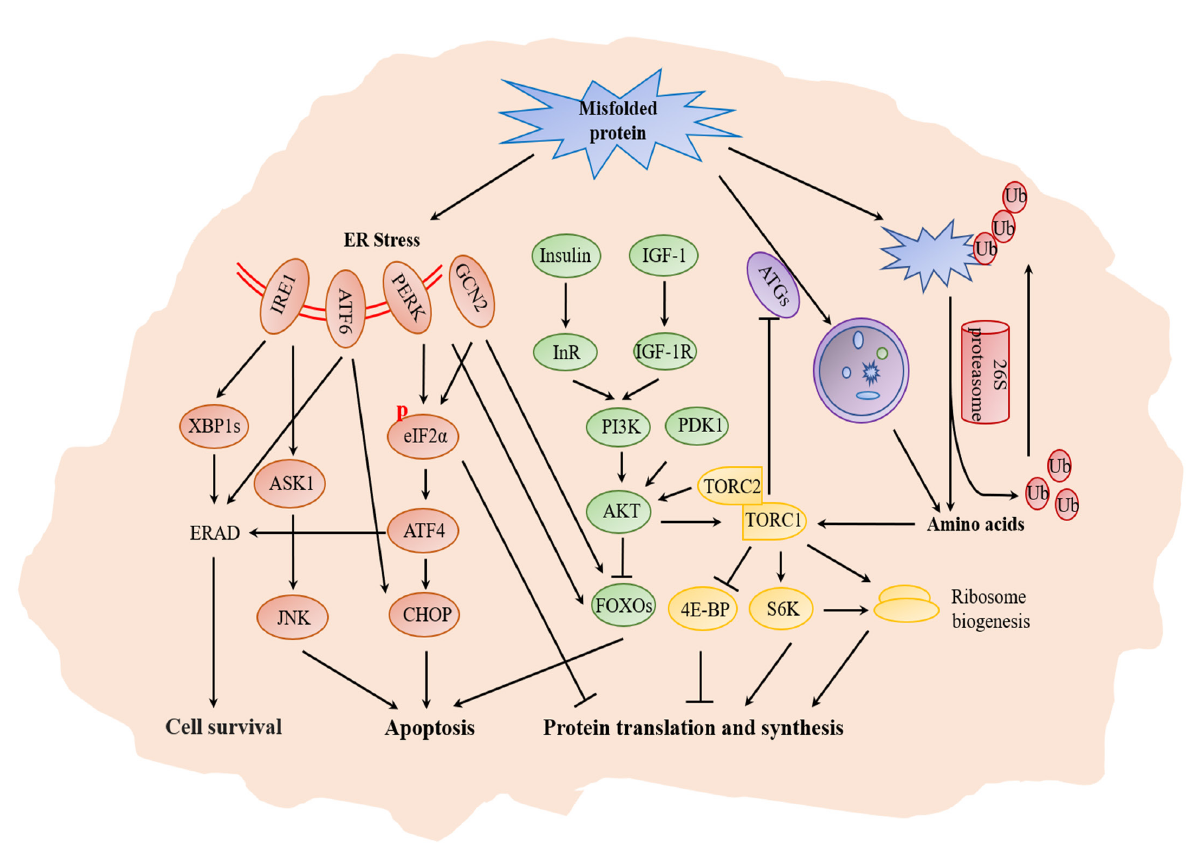
Figure 1. Schematic representation of cellular pathways involved in NDs. Arrows indicate activation, whereas bar-ended lines indicate inhibitory